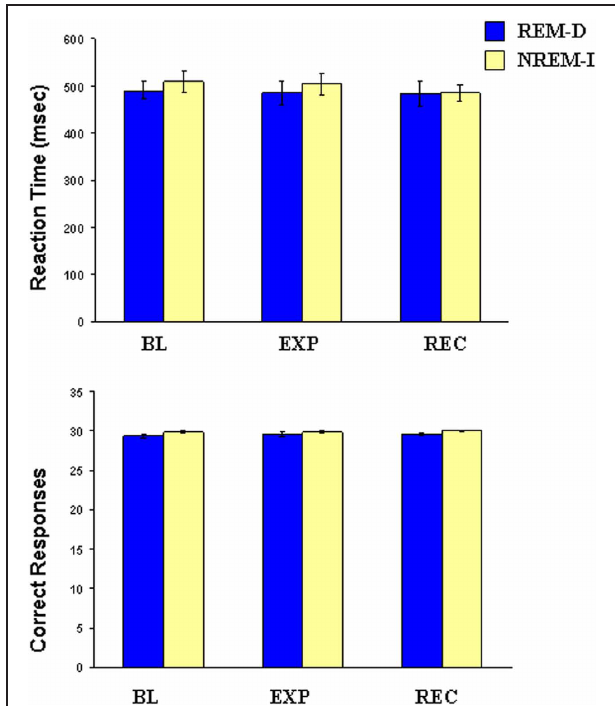
FIGURE 4 | Mean and standard error of reaction time and number of correct responses in the Visual Sustained Attention Task at baseline (BL), experimental (EXP) and recovery (REC) nights for the REM sleep deprivation (REM-D), and non-REM sleep interruptions (NREM-I)